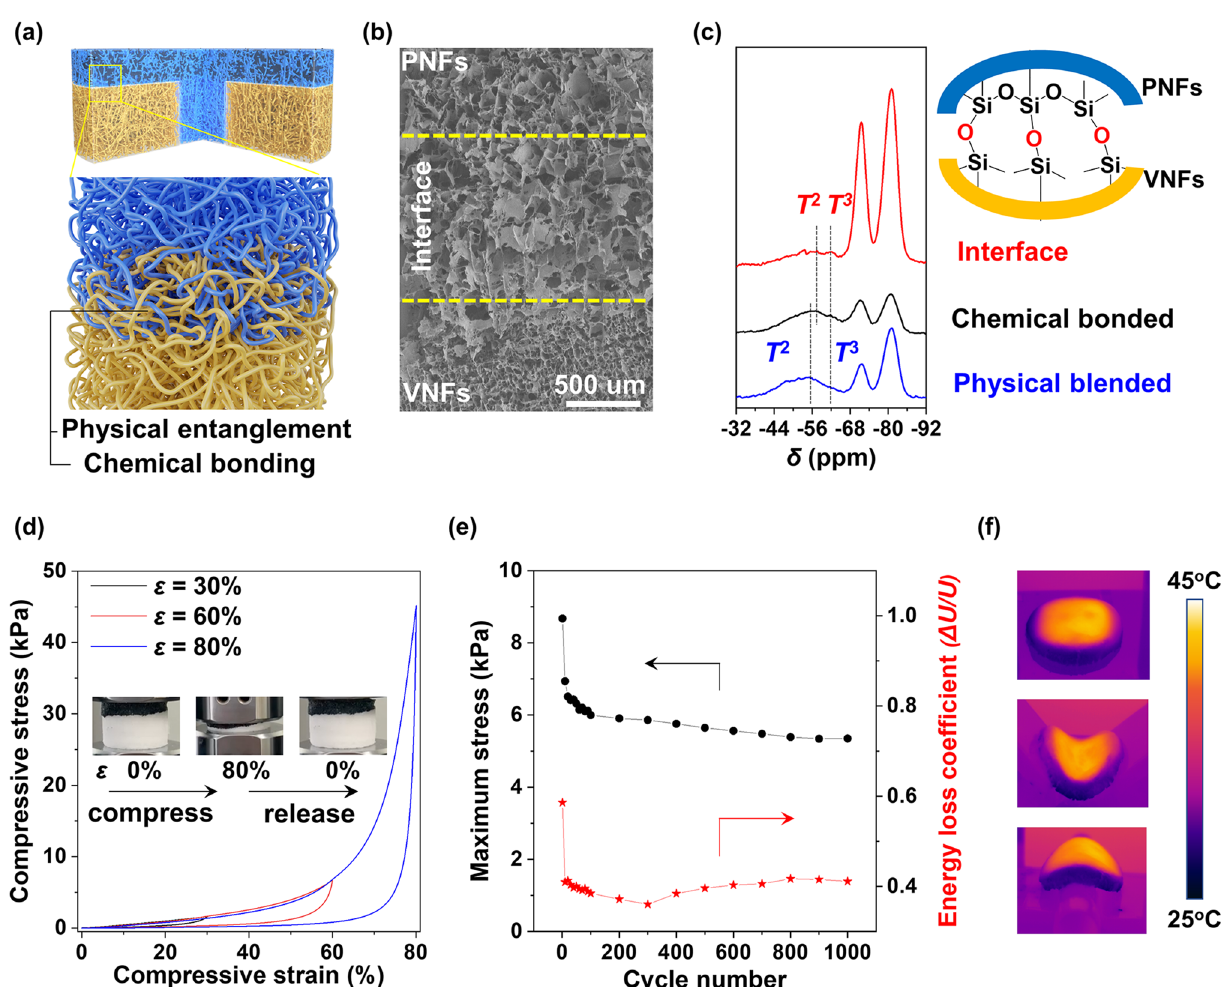
Fig. 5 Robust interface for evaporator structural stability. a Schematic illustration of interface aera of the evaporator, showing physical entan- glement between VNFs and PNFs. b SEM image of the evaporator interface area. c 29 Si NMR spectra of polysiloxane at the interface area, chemically bonded PVSQ-PVPSQ, and physically blended PVSQ and PVPSQ. d Compressive stress–strain curves of the aerogel evaporator with incremental strains of 30%, 60%, and 80%, respectively. e Maximum stress and energy loss coefficient versus compressive cycles. f Infrared thermal images of our evaporator in either flat, inward bending, or outward